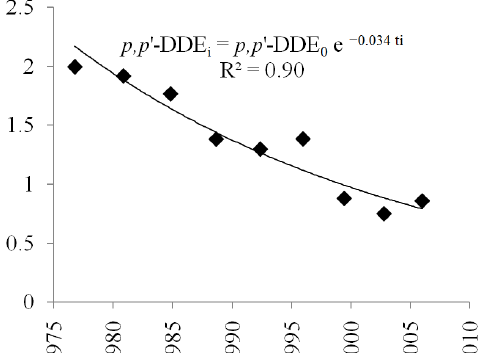
Figure 3. Decrease of p,p’ -DDE concentrations (ng/g dw) as a relation to “time”. The decrease rate, λ = − 0.034.